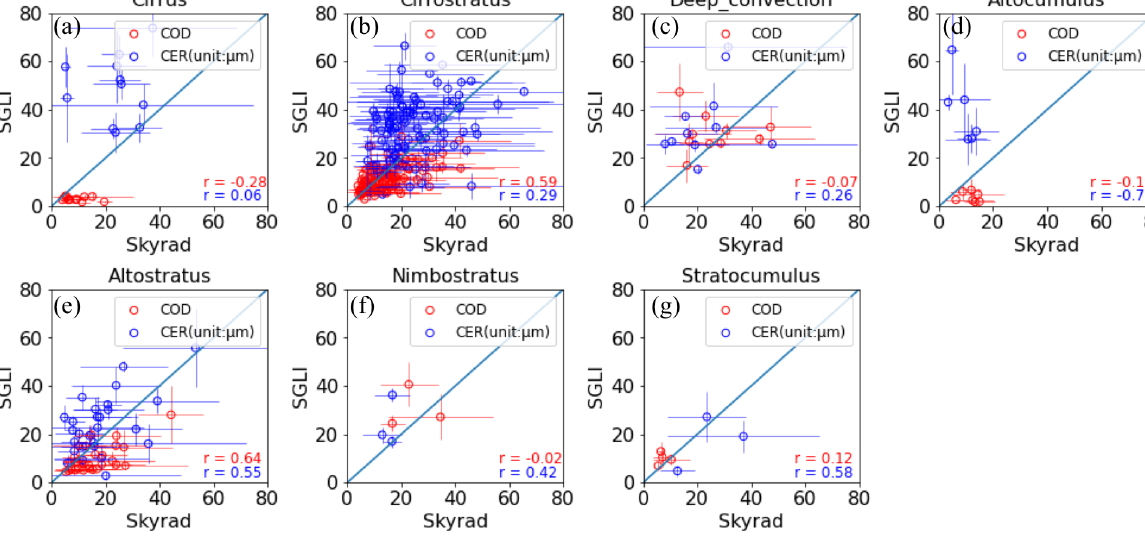
Figure 6. As Fig. 5 but for ice cloud